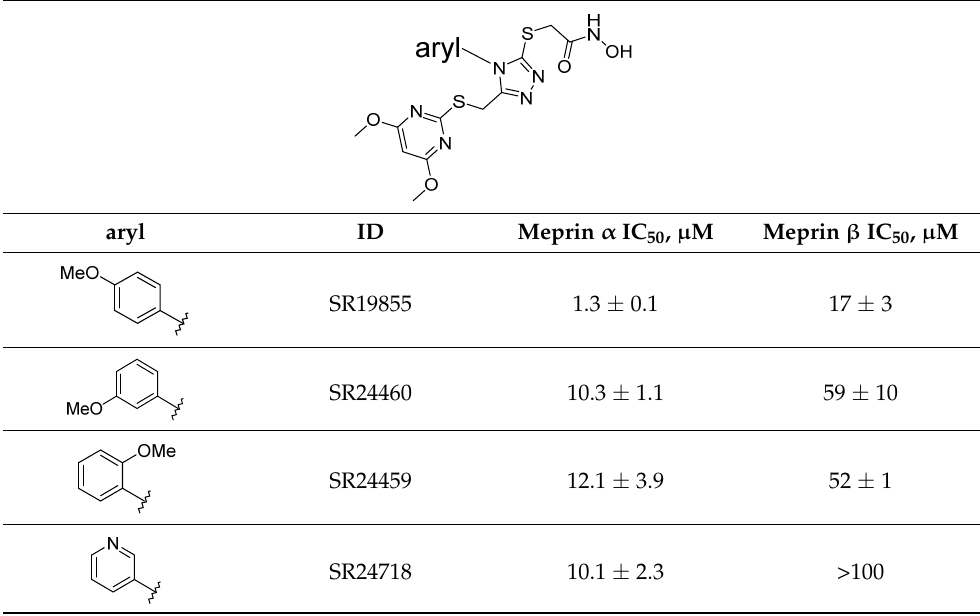
Table 2. SAR studies in the central aromatic ring.